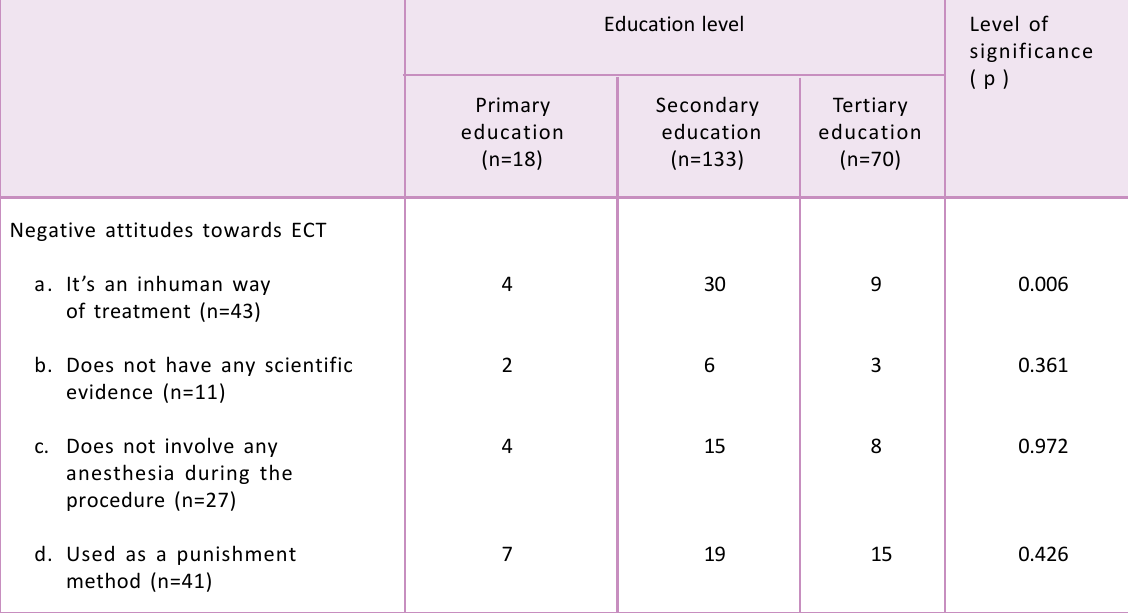
Negative attitudes towards